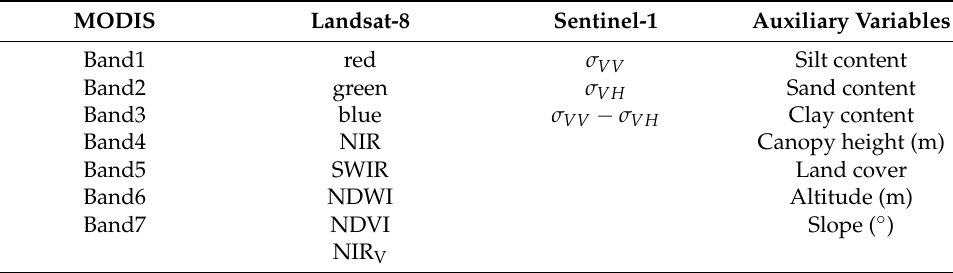
Table 1. Input variables of LFMC retrieval